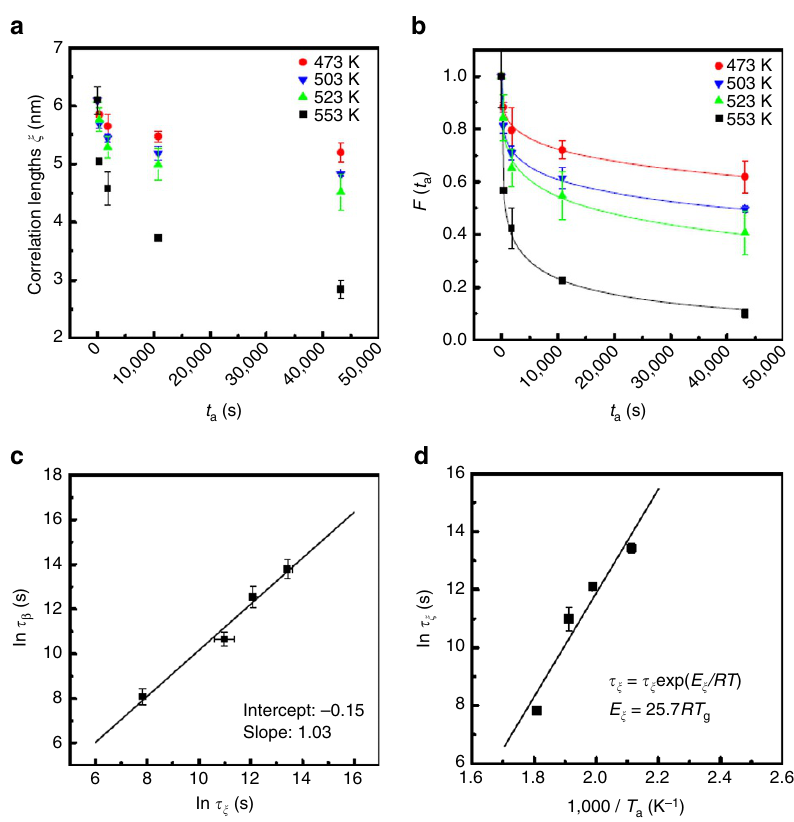
Figure 4 | Dynamics of the nanoscale spatial heterogeneity. ( a ) The evolution of the correlation lengths x of the samples relaxed at 473K, 503K, 523K and 553K for different durations. ( b ) Annealing duration t a dependences of the normalized correlation length cubed F ( t a ). ( c ) A comparison between the characteristic relaxation times t b and t x derived from the sub- T g enthalpy relaxation and the evolution of spatial heterogeneity, respectively. ( d ) The activation energy of the evolution of spatial heterogeneity derived from the dependence of characteristic relaxation time t x of the spatial heterogeneity volumes on the reciprocal annealing temperature (1/ T a ). The error bars indicate standard deviation.